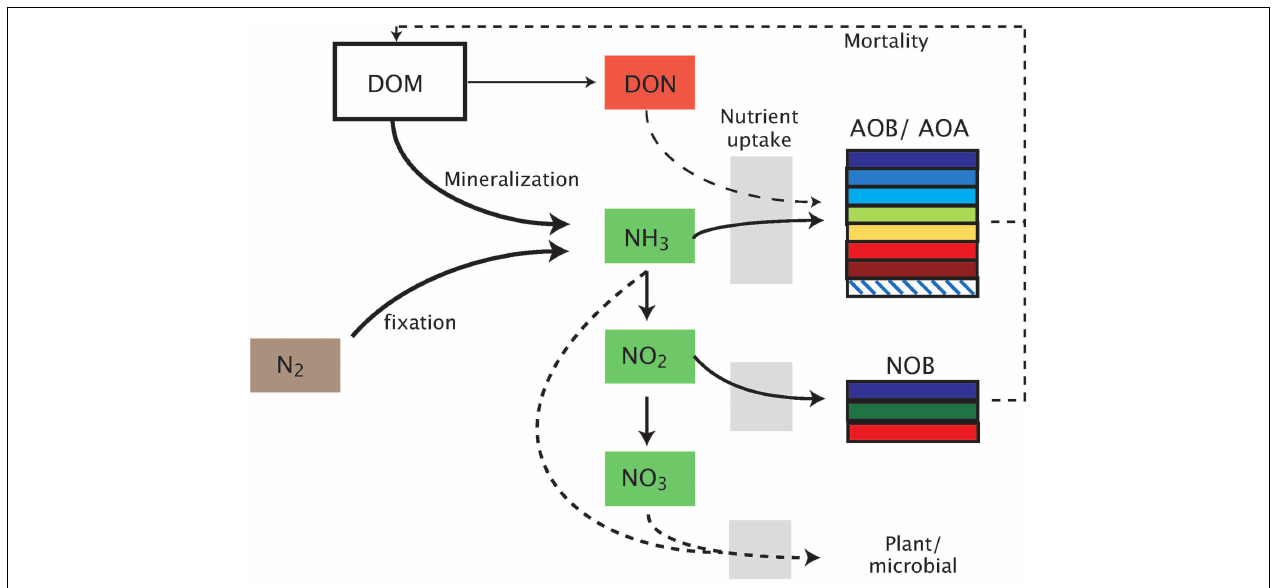
FIGURE 1 | Schematic representation of the model. Model abbreviations. DOM, dissolved organic matter; DON, dissolved organic nitrogen; AOB/AOA, ammonia-oxidizing bacteria/archaea; NOB, nitrite-oxidizing